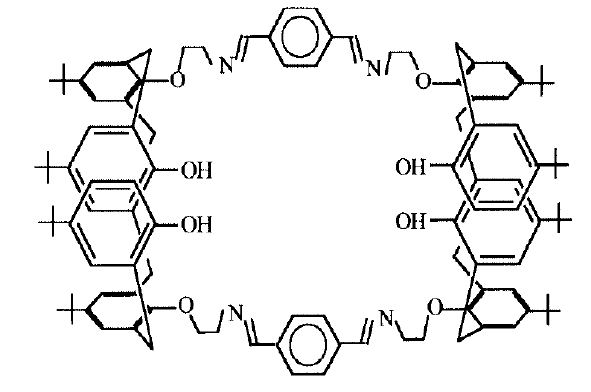
Figure 19. Schiff's base– p-tert